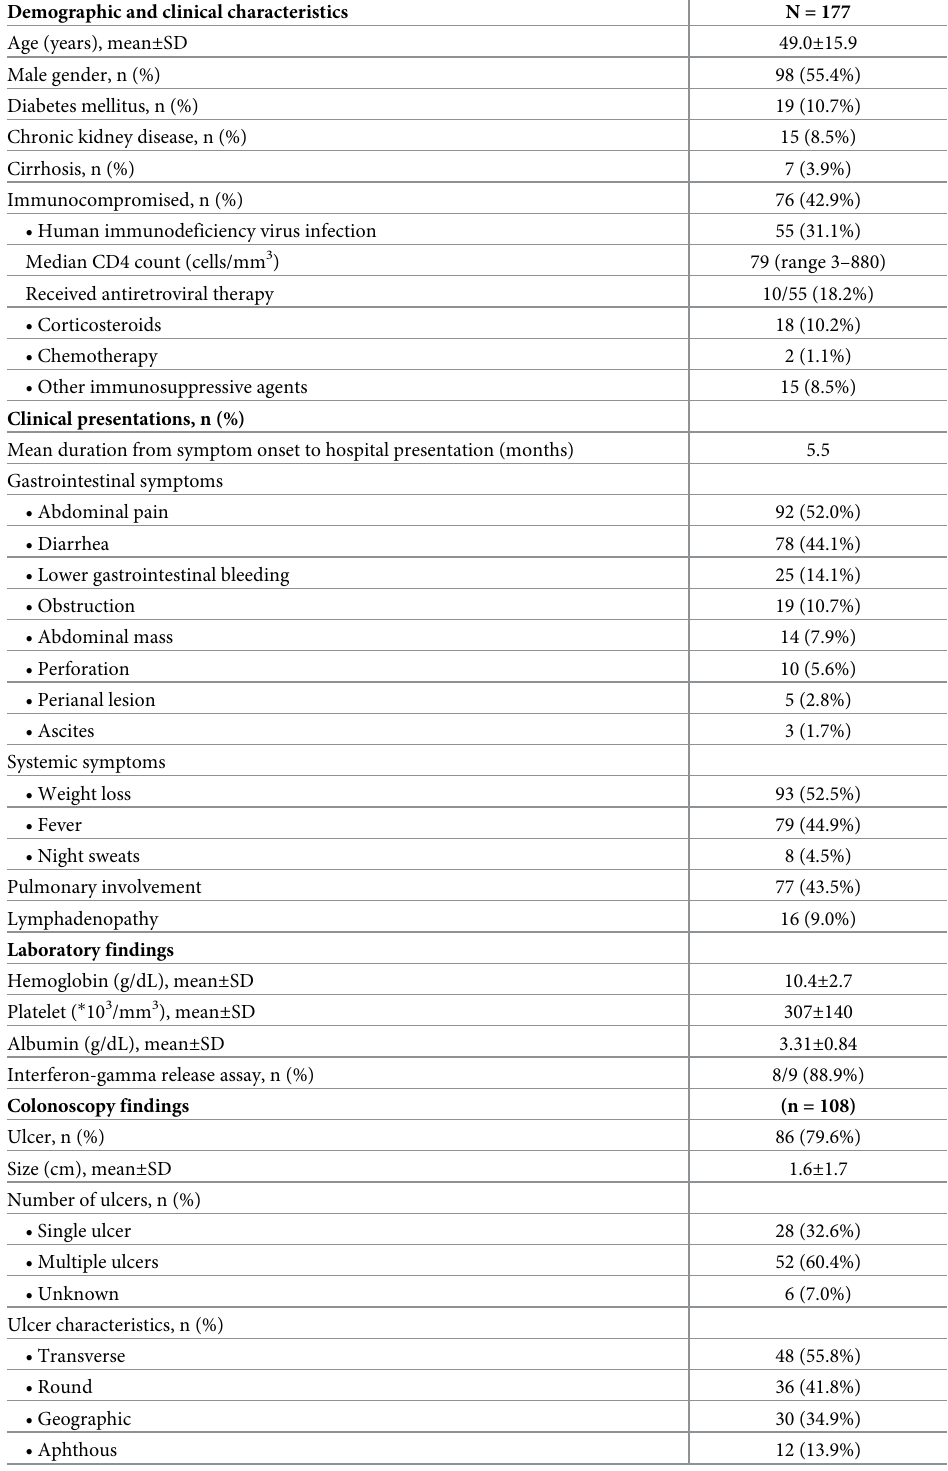
Table 1. Baseline demographic and clinical characteristics, clinical presentations, laboratory findings, colonos- copy findings, computed tomography findings, and histopathology findings in patients diagnosed with intestinal